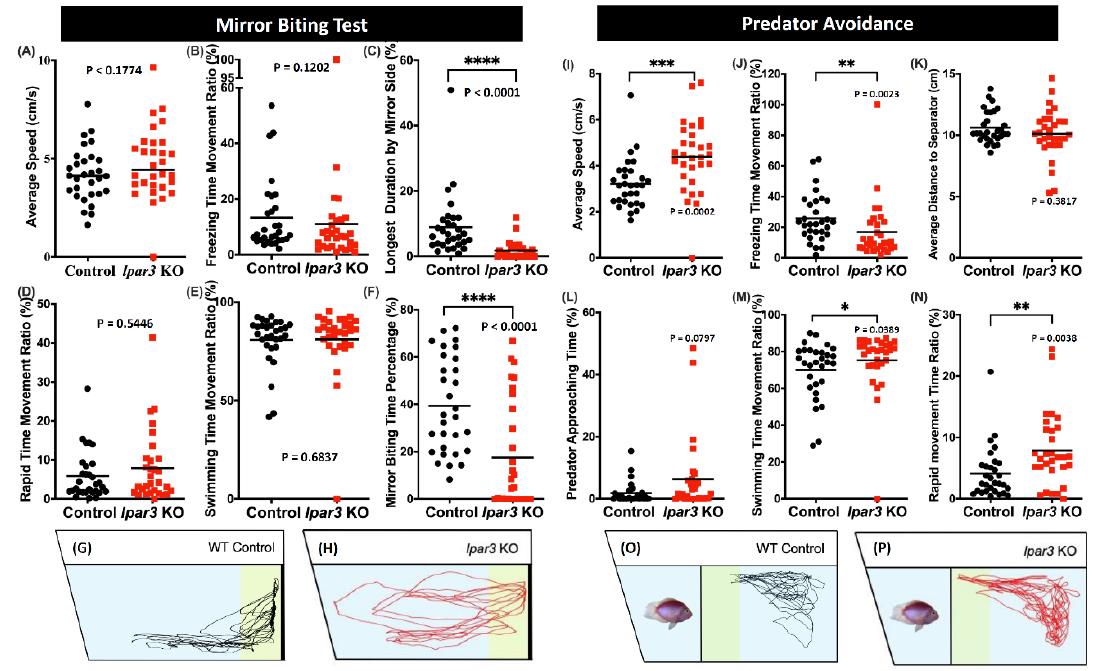
Figure 3. Comparison of behavior endpoints between wild-type (black) and lpar3 KO (red) fish in mirror biting ( A – H ) and predator avoidance ( I – P ) tests. In the mirror-biting test, average speed ( A ), freezing time movement ratio ( B ), longest duration in the mirror side ( C ), rapid time movement ratio ( D ), swimming time movement ratio ( E ), and mirror biting time percentage ( F ) were analyzed. Locomotor trajectories of wild-type ( G ) and lpar3 KO fish ( H ) for mirror biting assay were plotted to facilitate visualization. Average speed ( I ), freezing time movement ratio ( J ), average distance to the separator ( K ), predator approaching time ( L ), swimming time movement ratio ( M ), and rapid movement ratio ( N ) were analyzed during the predator avoidance test. Locomotor trajectories of wild-type ( O ) and lpar3 KO fish for predator avoidance assay were plotted to facilitate visualization. The data are expressed as the median and were analyzed by Mann–Whitney test ( n = 30 for both groups; * p < 0.05, ** p < 0.01, *** p < 0.001, **** p < 0.0001).